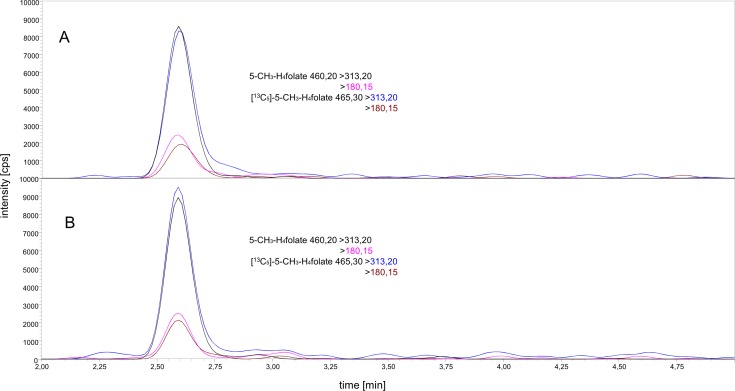
Comparison of the matrix effect of K3 EDTA and lithium-heparin.Extraction of 60 μL plasma drawn with a K3 EDTA coated tube (A) and lithium-heparin coated tube (B); 5-CH3-H4folate m/z 460.20 → 313.20 (black), 460.20 → 180.15 (pink), and [13C5]-5-CH3-H4folate m/z 465.30 → 313.20 (blue), 460.30 → 180.15 (brown).